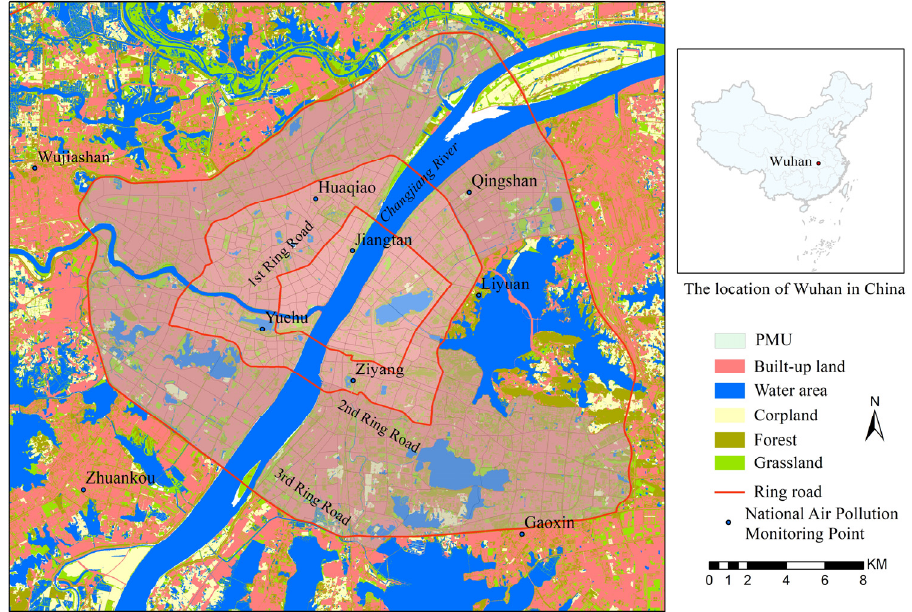
Figure 1. Study area location.